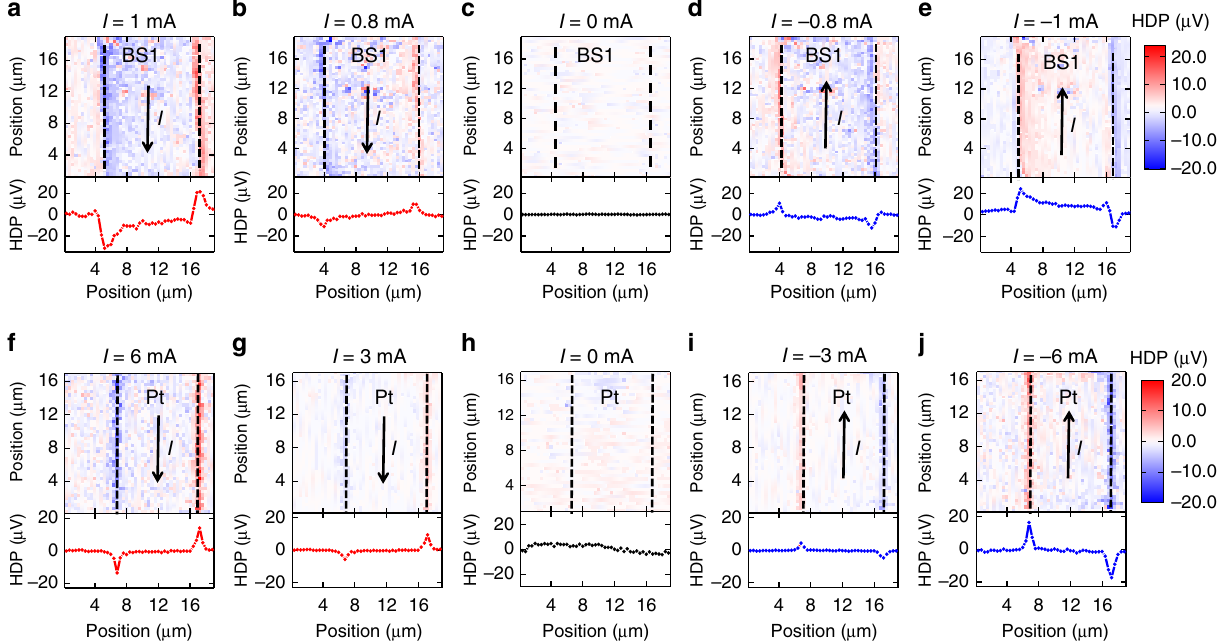
Fig. 2 Current induced spin accumulations in Bi 2 Se 3 and Pt. a – e Spatial two-dimensional HDP maps in BS1 under bias currents of 1 ( a ), 0.8 ( b ), 0 ( c ), − 0.8 ( d ), and − 1 mA ( e ). f – j Spatial two-dimensional HDP maps in Pt under bias currents of 6 ( f ), 3 ( g ), 0 ( h ), − 3 ( i ), and − 6 mA ( j ). Black dashed lines indicate the edges of the device. Black arrows show the applied bias current direction